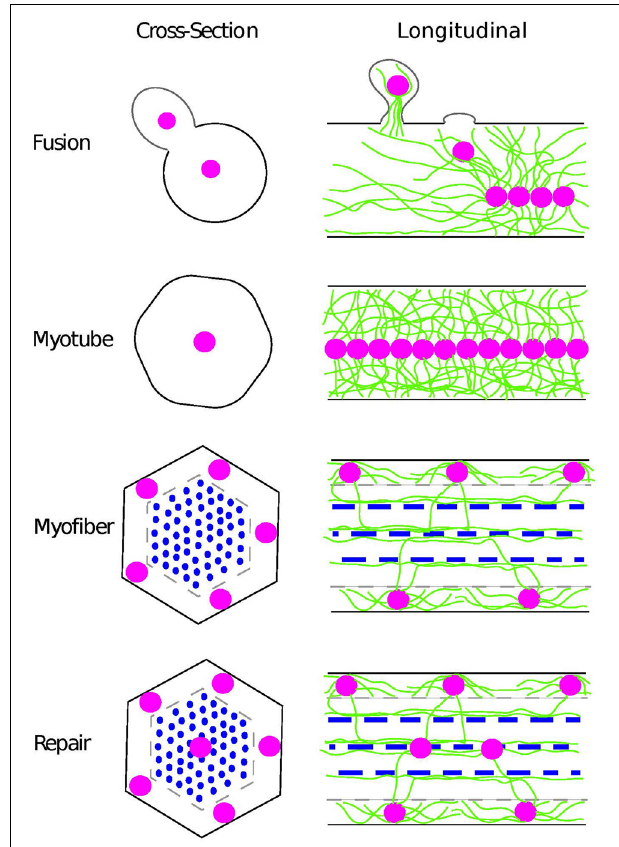
FIGURE 1 | Position of nuclei during muscle development as seen in cross-section (left) and longitudinal samples (right). As new nuclei (pink) are incorporated from myoblasts during fusion, they are rapidly moved to the center of the myotube by a process that requires the microtubule cytoskeleton (green). Thus, in the myotube, the nuclei are aligned in the center of the cell. As the myotube matures into a myofiber with the assembly of the sarcomere (blue), the nuclei move to the periphery of the muscle and reside directly above the sarcolemna (gray) and space to maximize the internuclear distance. Coincident with these nuclear movements, the microtubule cytoskeleton becomes highly ordered. Microtubules are nucleated at or near the nuclear envelope with some overlap of microtubules emanating from adjacent nuclei. Additionally, microtubules extend to the sarcomeres and run parallel to these highly ordered actin-myosin based structures. During repair, newly incorporated nuclei undergo movements similar to the movements of nuclei in the developing muscle. New nuclei are incorporated into the myofiber as myotubes fuse with the myofiber. The newly incorporated nuclei move to the center of the myofiber before moving out to the myofiber periphery in two separate microtubule-dependent